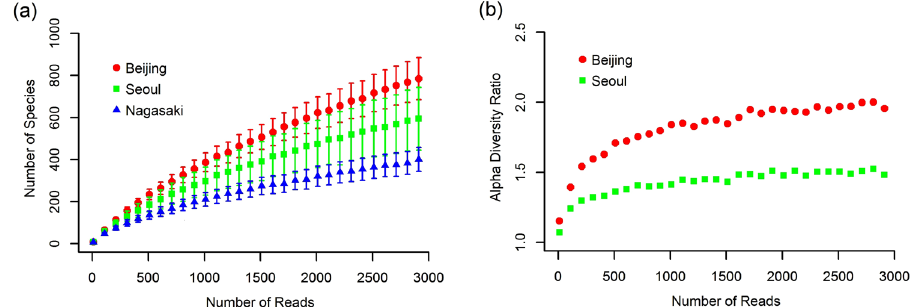
Figure 3. ( a ) Diversity versus number of reads at the species level at each measurement site. Red circles, green rectangles, and blue triangles represent the numbers of species in the Beijing, Seoul, and Nagasaki sites, respectively. ( b ) Diversity of the Beijing (red circles) and Seoul (green rectangles) sites divided by that of the Nagasaki site.